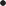
Effects of FR900359 and L-NAME on acetylcholine and relaxin-2 induced relaxations. (A) Summary data for relaxin-2 induced relaxationsin arteries in the presence of L-NAME (100 μM, 30 min) (, n = 6 out of four mice), in the presence of FR900359 (100 nM, 30 min) (, n = 6 out of four mice), and in non-treated arteries (control group) (∙, n = 6 out of four mice). (B) Summary data for ACh-induced relaxations in arteries in the presence of L-NAME (100 μM) (, n = 6 out of four mice), in the presence of FR900359 (100 nM) (, n = 6 out of four mice), and non-treated arteries (control group) (, n = 6 out of four mice). ∗P < 0.05 for relaxin-2 + L-NAME vs. control or ACh + L-NAME vs. non-treated vessels or ACh + FR900359 vs. non-treated vessels; repeated-measures two-way ANOVA, followed by Bonferroni post hoc test.